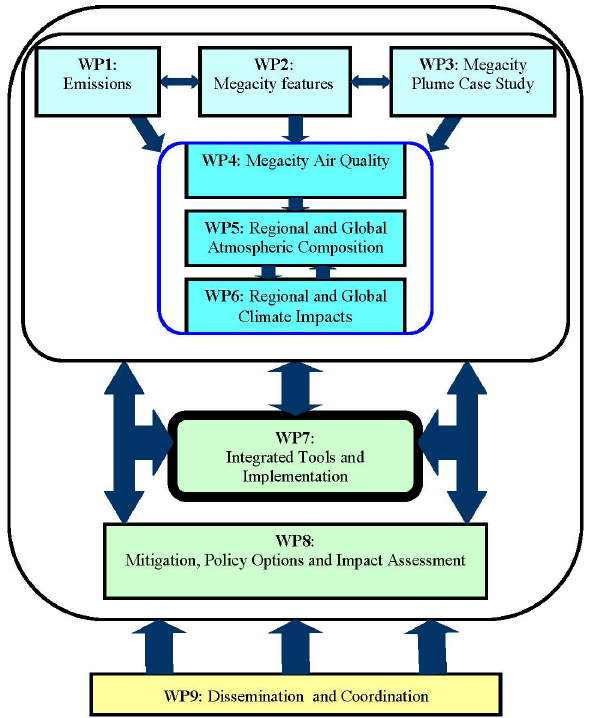
Figure 3 : MEGAPOLI Work Packages (WPs) structure and linkage. Figure 3. MEGAPOLI Work Packages (WPs) structure and